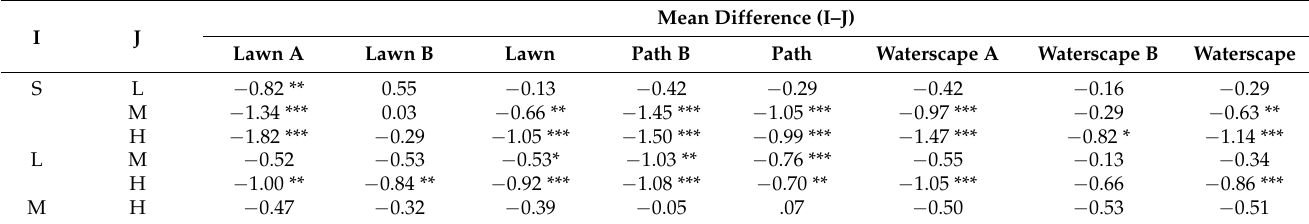
Figure 3. The mean of participants’ preference ratings for the four images in each group. Error bar: standard error. Table 2. Tukey’s HSD test results for individuals’ preference in groups.